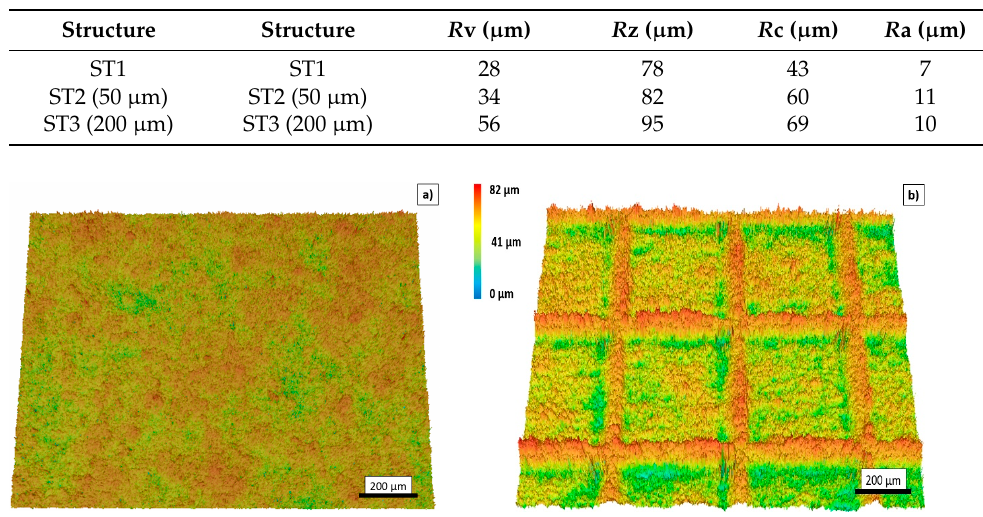
Table 2. Determined roughness values of Specimen type 1–3.